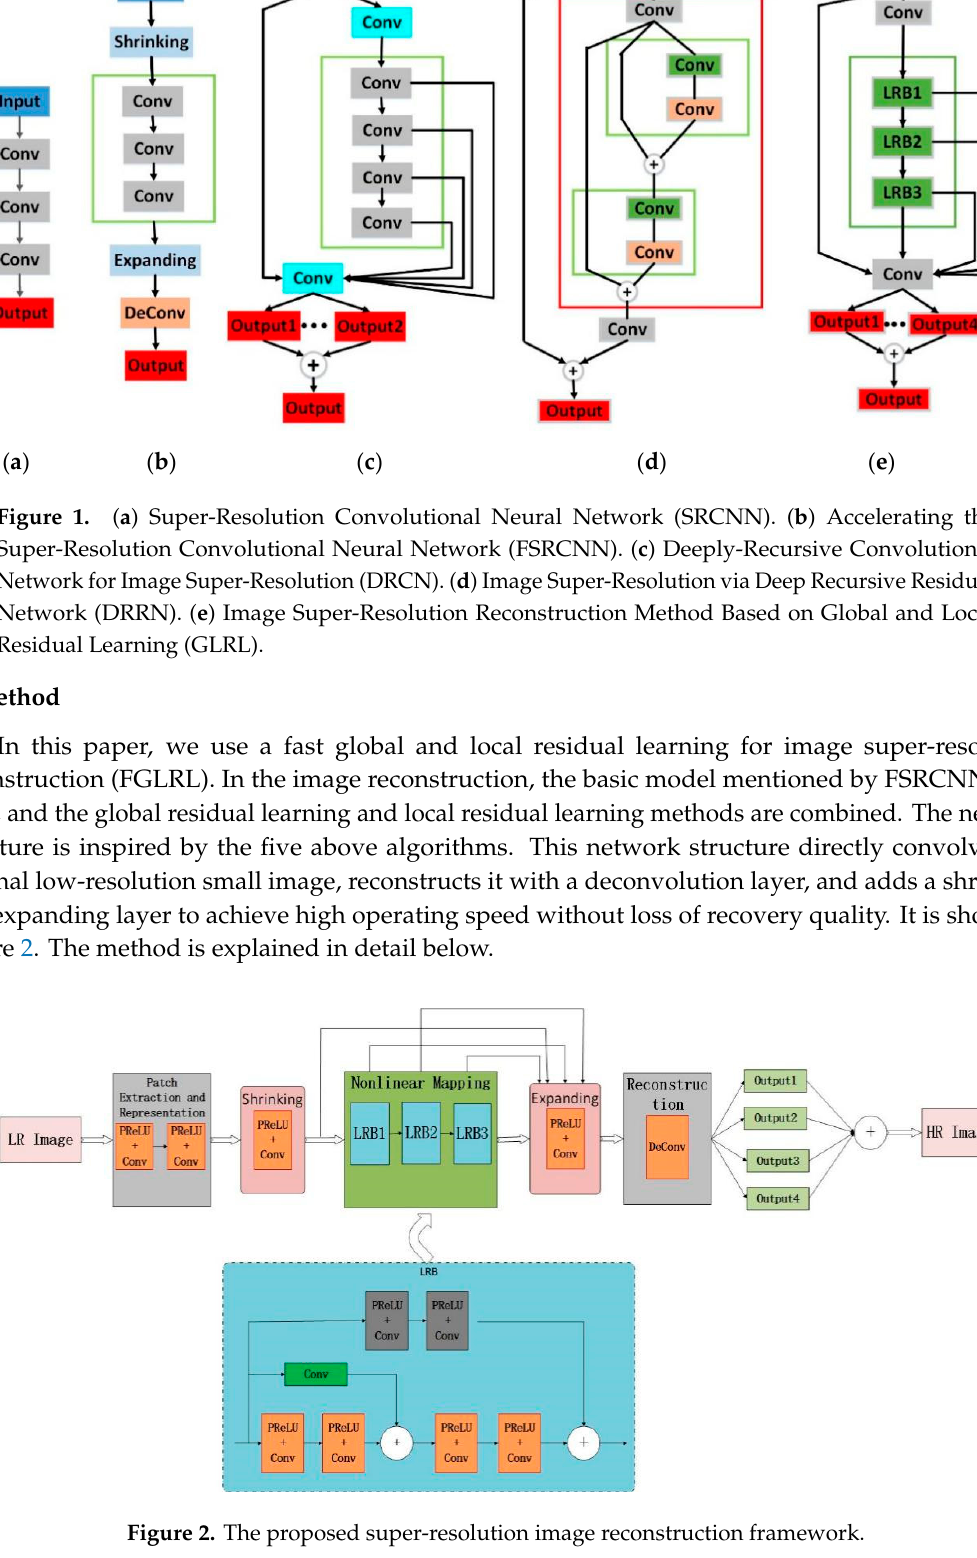
same weights. Figure 1e represents the network structure of GLRL, where LRB [14] represents the local residual block. ⊕ is the element-wise addition. Appl. Sci. 2020 , 10 , x FOR PEER REVIEW